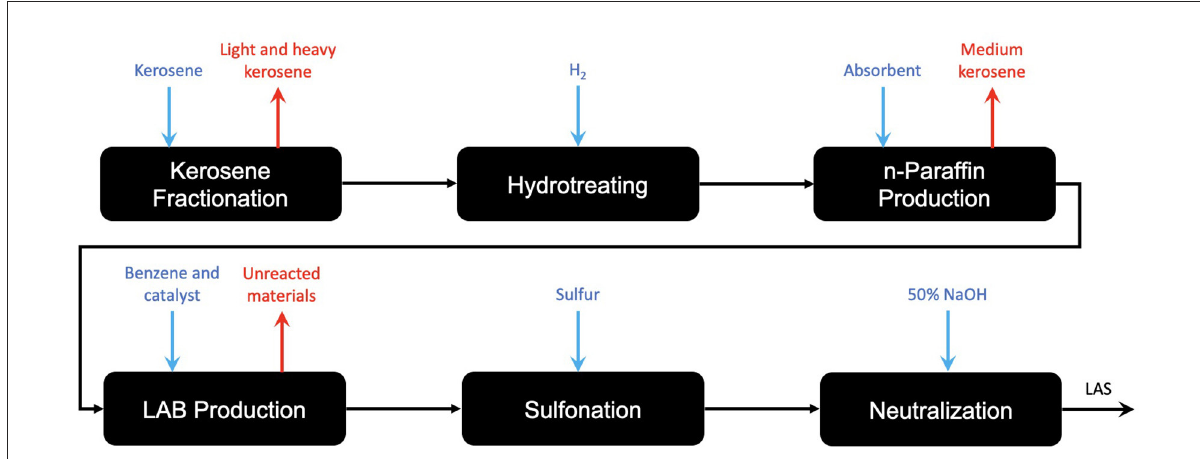
FIGURE1 A process route diagram for the production of a renewable and a petroleum-based LAS production, illustrating the shared pathway following the production of the alkyl (olefin) route (after Fogliatti et al.,